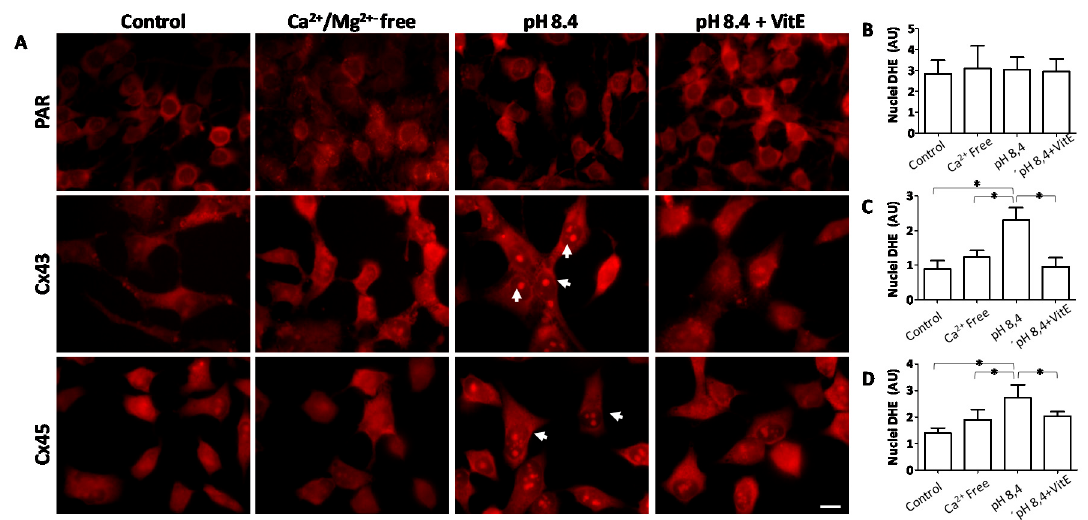
Figure 6. Ca 2 + enters into cytoplasm and increases ROS generation in transfected HeLa cells. To measure ROS generation, the oxidation of dihydroxy ethidium (DHE) was visualized in HeLa-Parental, HeLa Cx43 and HeLa Cx45 cells exposed to control conditions and after exposure to (Ca 2 + / Mg 2 + free) Krebs solution, alkaline solution (Krebs 8.4 pH) and alkaline solution with 300 µ M VitE. ( A ) Representative images of nuclear DHE fluorescence. White arrow-heads indicate DHE positive nuclei. ( B – D ) Graphs showing the number of DHE fluorescence nuclei that was quantified using Image J software. n = 3 independent experiments. ( B ) HeLa parental cells, ( C ) HeLa Cx43 cells and ( D ) HeLa Cx45 cells. Three images from three independent experiments were evaluated * p < 0.05. Scale bar: 20 µ m.